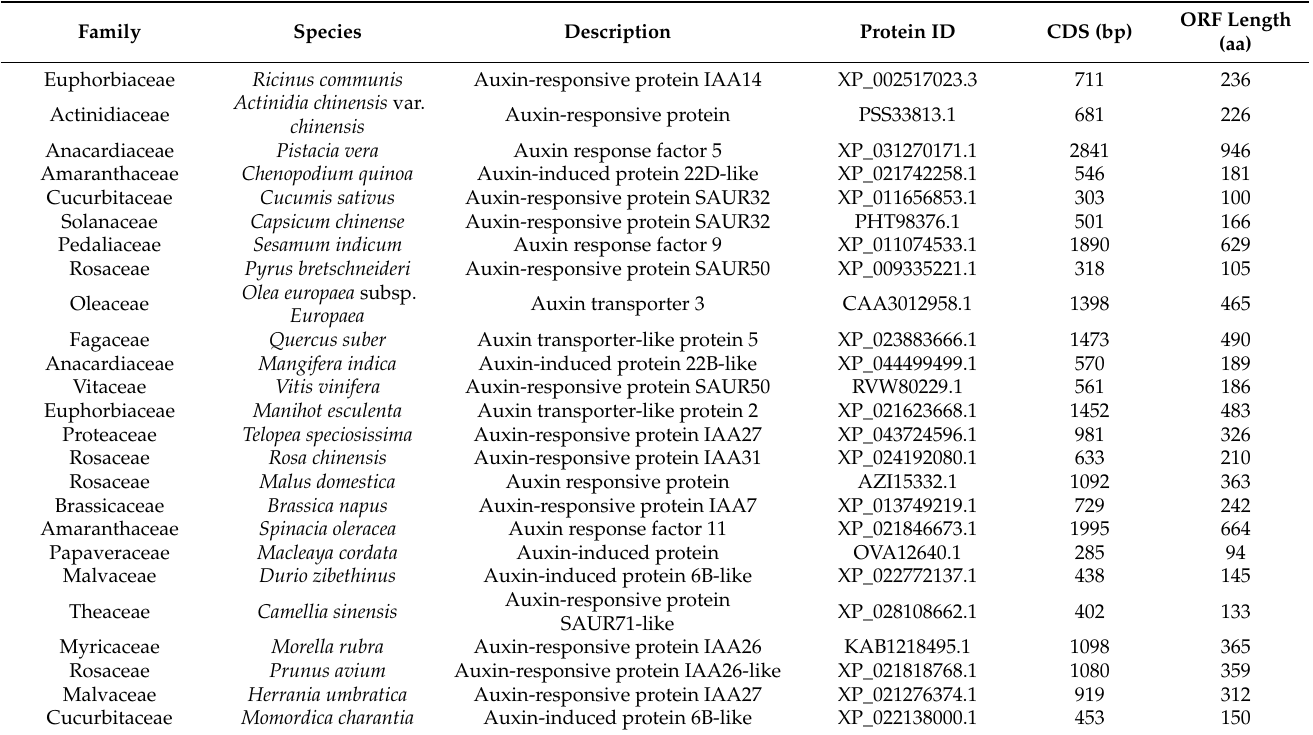
Table 3. Information sheet for 25